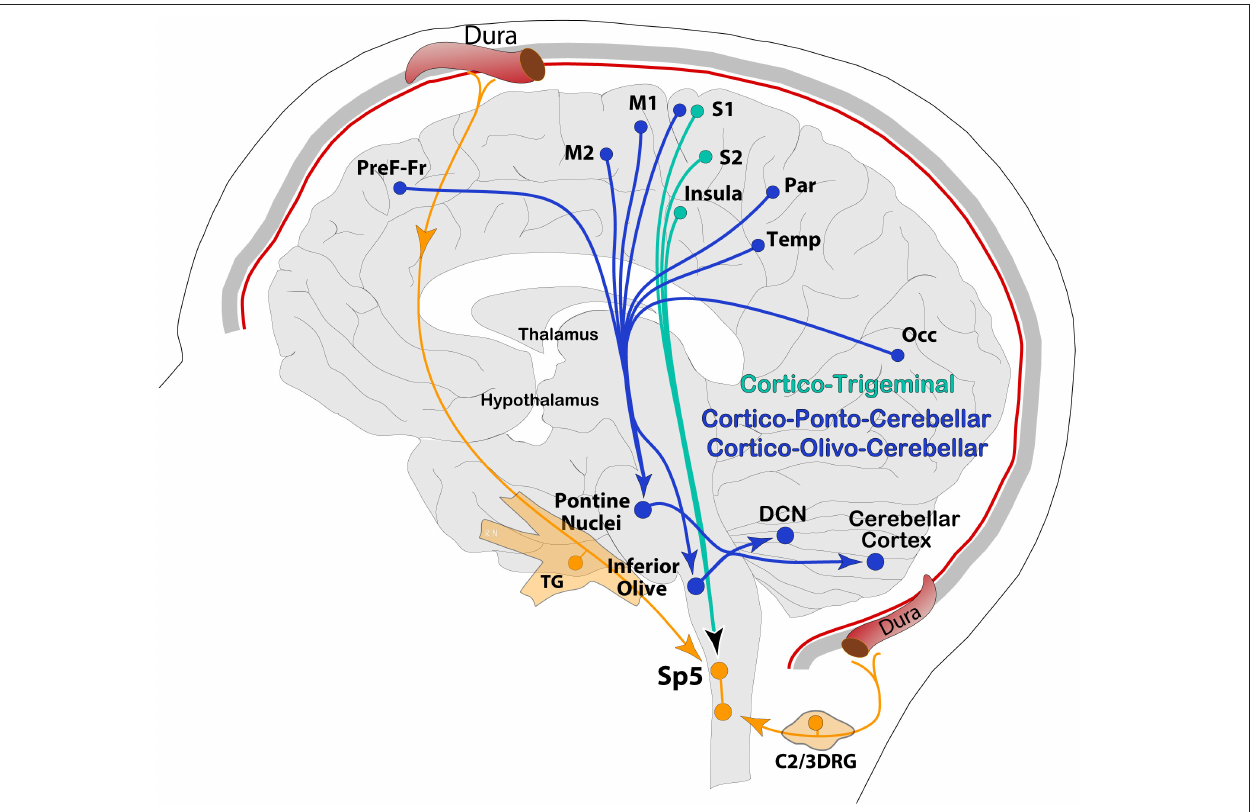
FIGURE 4 | Schematic representation of the cerebral cortex, descending pathways from a variety of cortical areas to pre-cerebellar nodes (PN, IO) via cortico-ponto-cerebellar and cortico-olivo-cerebellar pathways, and to the trigeminocervical complex and reticular formation via cortico-trigeminal projections. Occ, occipital; Temp, temporal; Par, parietal; PreF-Fr,